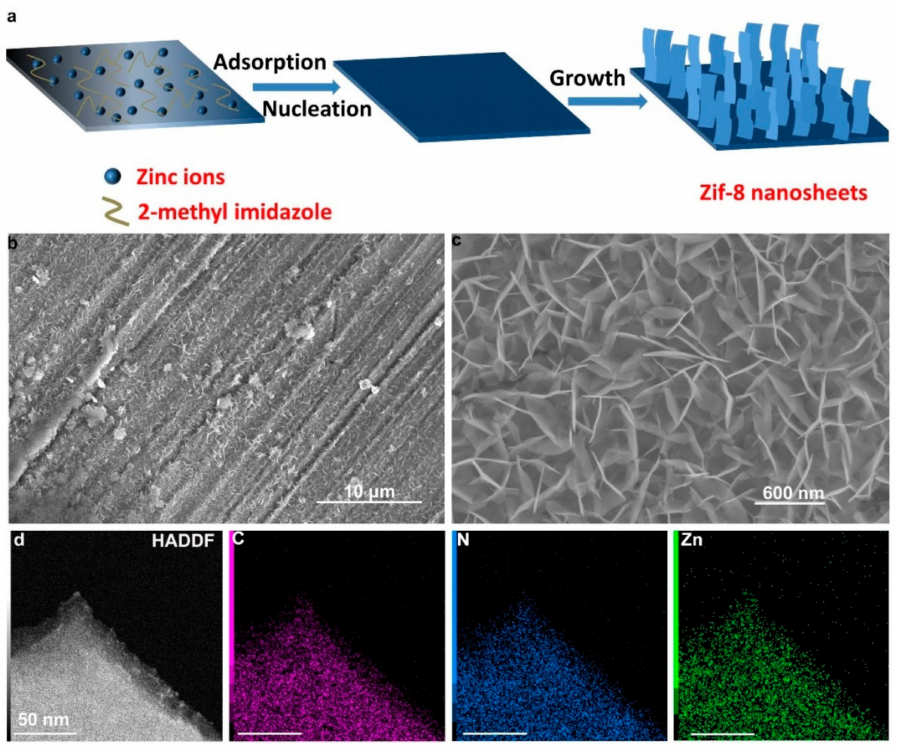
Figure 1. ( a ) Schematic illustration of the synthesis process. ( b , c ) SEM images of the Zif-8 coating sample. ( d ) STEM image and the corresponding elemental mapping images of Zif-8 coating sample.